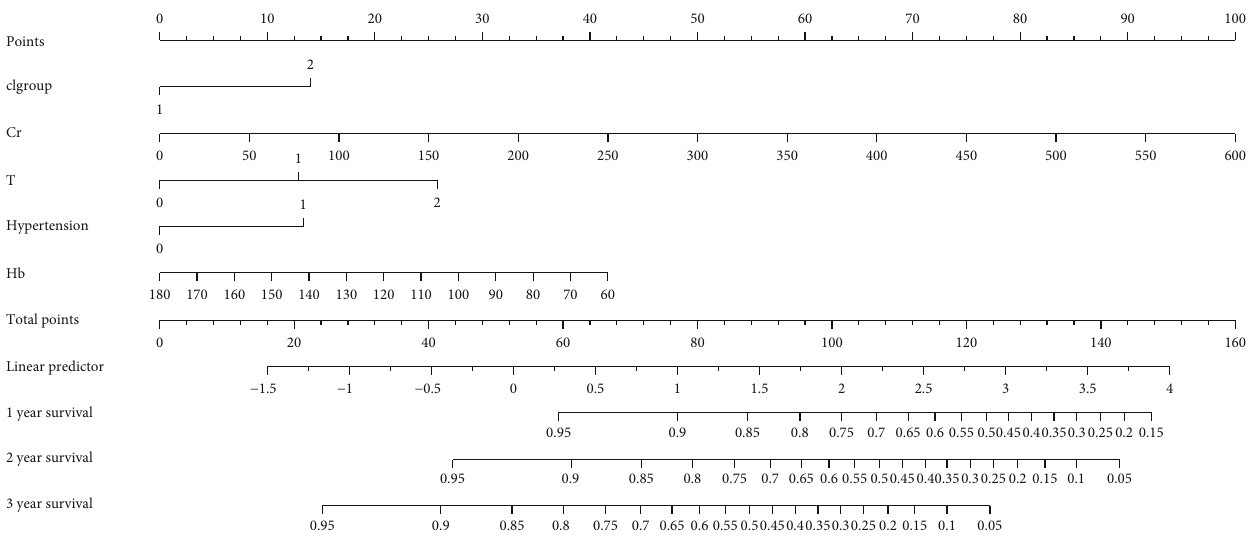
Figure 3: A nomogram predicting the probabilities of 1-, 2-, and 3-year renal survival. We built a nomogram based on the prognostic model (including sCr, hypertension, T, Hb, and serum chloride ( < 105.40mmol/L or ≥ 105.40mmol/L)). Higher total scores based on the sum of the assigned number of points for each factor in the nomogram were associated with a worse